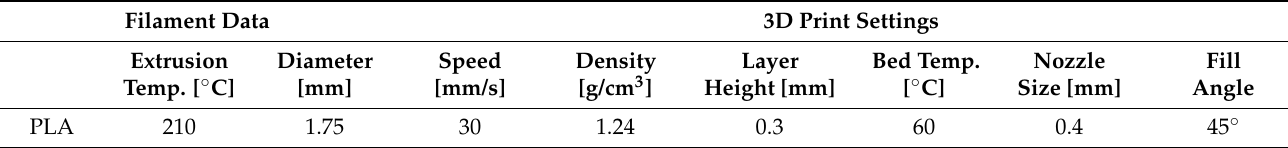
Table 1. Basic parameters of the 3D print polylactic acid (PLA) used to test the breaking strength of the bond with 100% cotton and 100% polyester fabric.